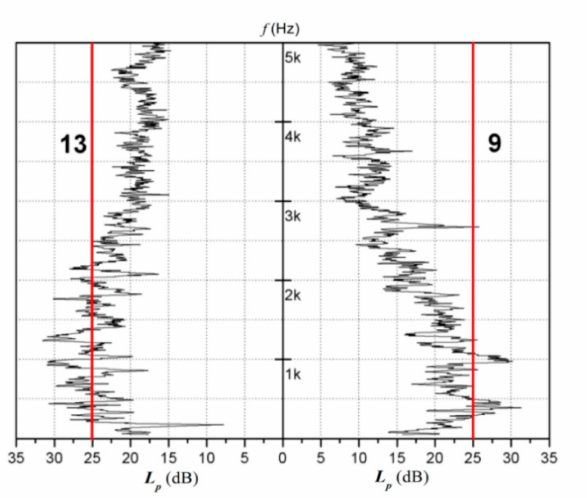
Figure 11. Frequency–spectrum comparison of measuring points 9 and 13 of the outlet at B-0.204 m 3 /s and 1000 rpm.